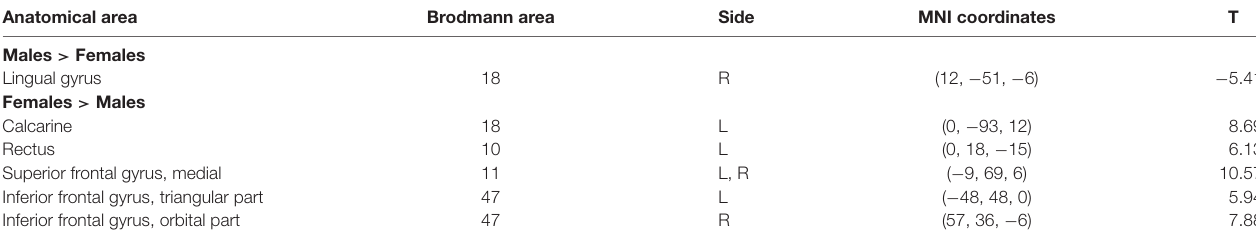
TABLE 2 | Brain areas showing sex differences in ReHo detected by univariate two-sample t -tests ( P < 0.05, FWE corrected). Anatomical area Brodmann area Side MNI coordinates T Males > Females Lingual